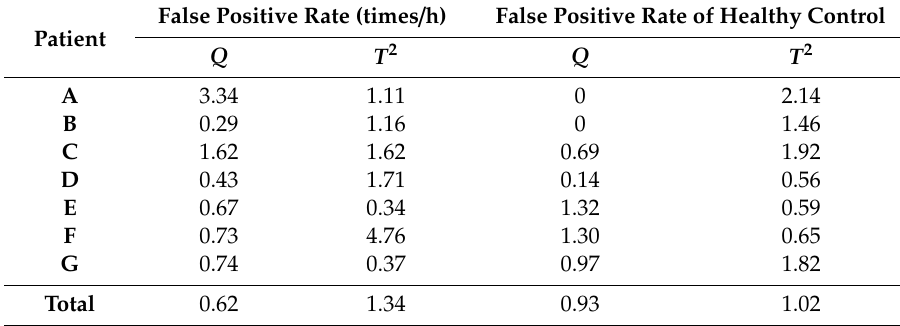
Table 5. False positive rate during interictal